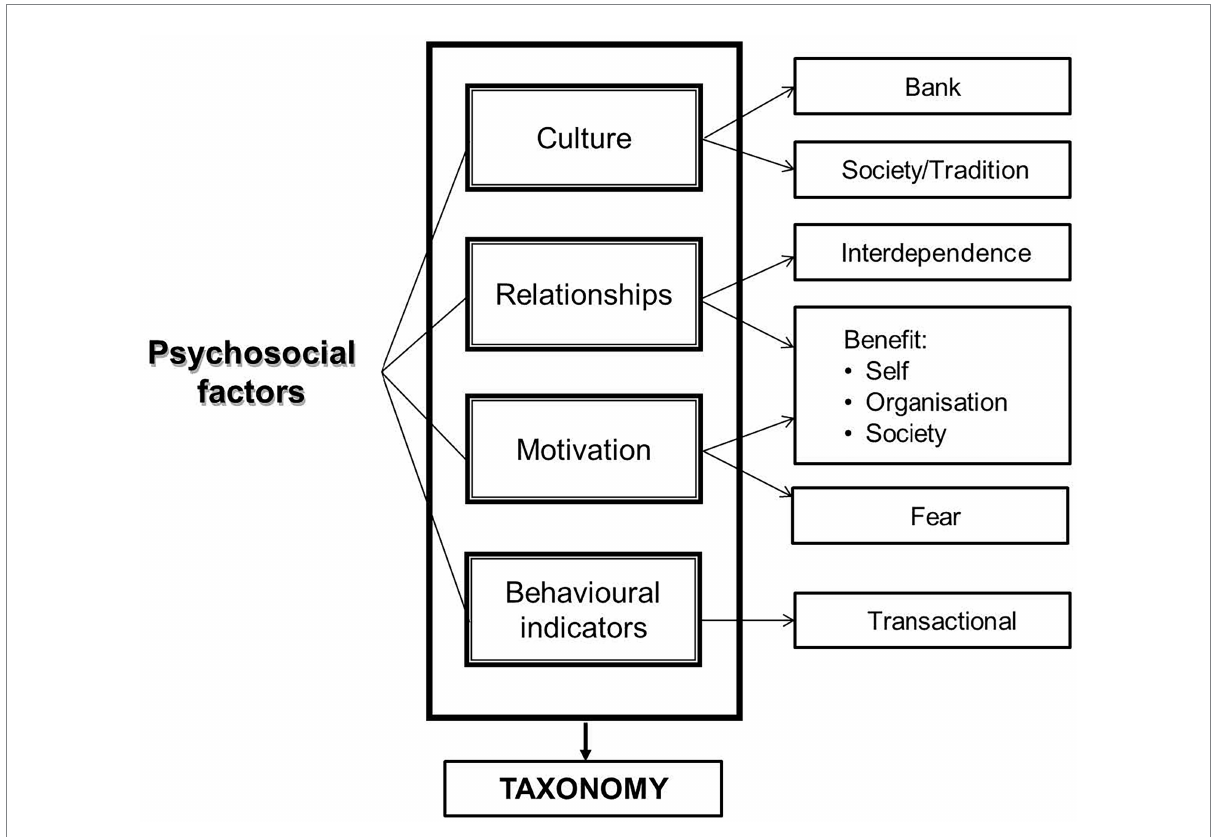
FIGURE 1 Aspects influencing psychosocial components (Van Niekerk et al.,